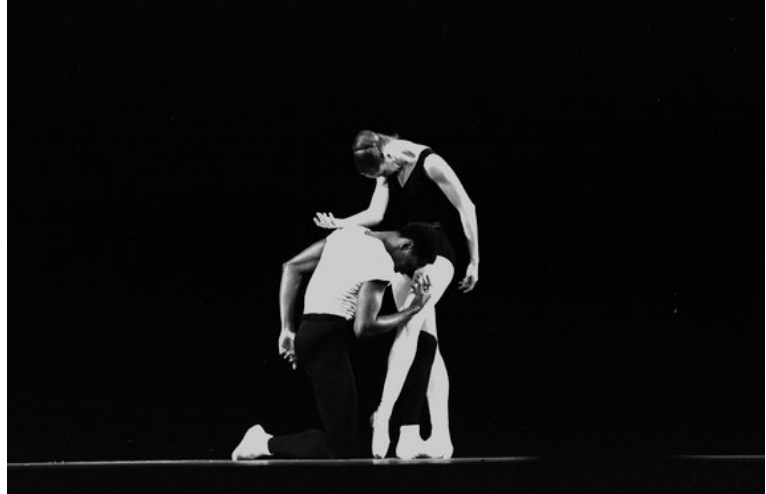
Figure 5. Agon duet by NYCB dancers Suzanne Farrell and Arthur Mitchell (1965). Photo © Martha Swope and New York Public Library, used with the permission.